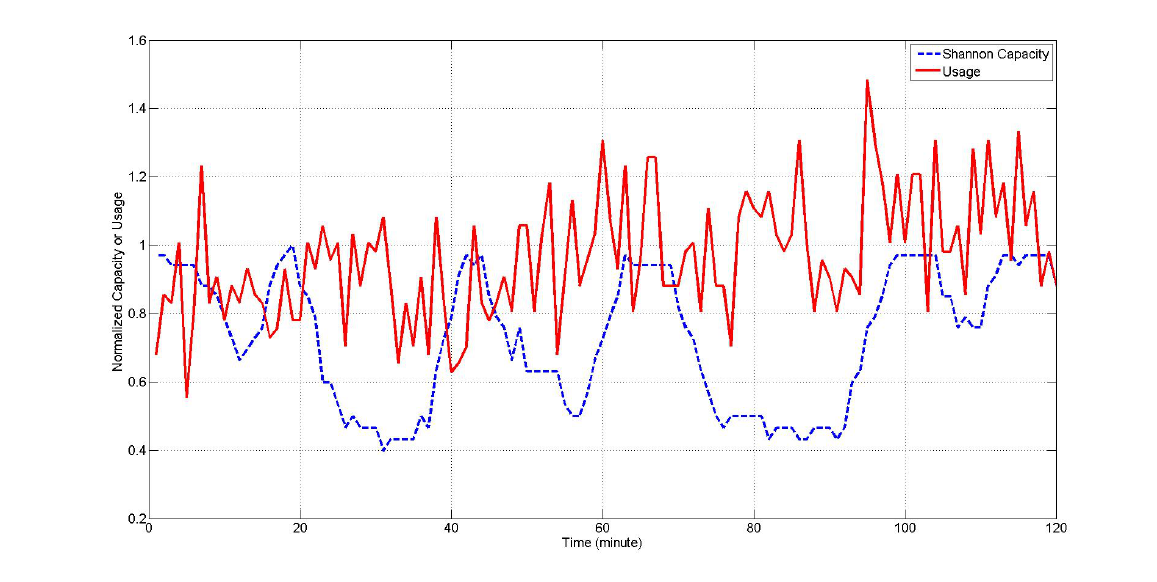
Figure 4. Comparison between a given demand for data transmission as a function of the number of the Tweets and calculated point-to-point communication Shannon capacity of a WiFi network based on the received signal strength measurements as function of the signal-to-noise ratio with respect to